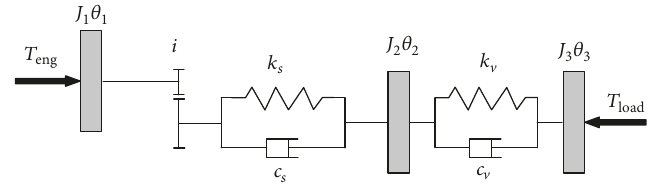
Figure 20: Structure of three-degree-of-freedom vehicle longitudinal vibration